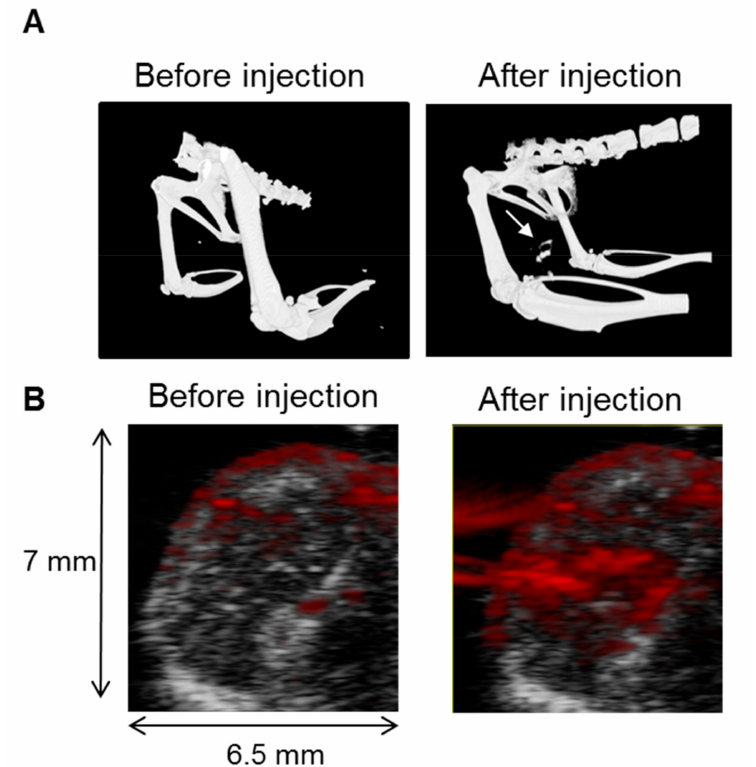
Figure 6. ( A ) CT images before and after injection of gold nanostars into the tumor. An increased contrast was noticed at the tumor site after gold nanostars injection as indicated by the arrow; ( B ) In vivo PA images before and 24 h after nanostar injection. The photoacoustic imaging (PAI) signal (red pixels) is overlaid over the anatomical ultrasound images (grey